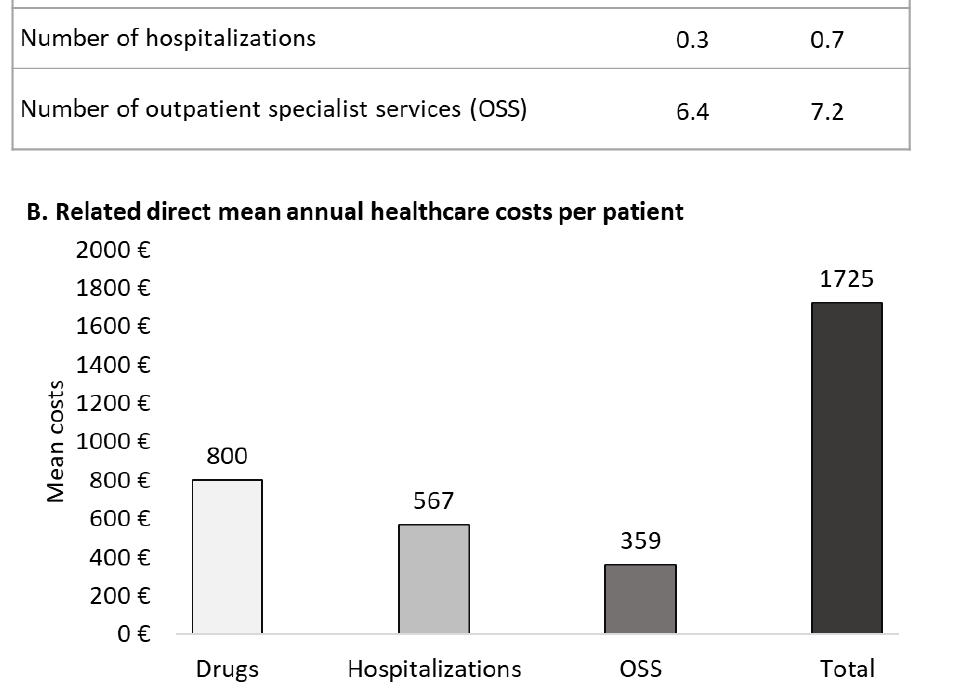
Figure 3. Mean annual healthcare resource consumptions ( A ) and related direct costs ( B ) over first year of follow-up in patients with glaucoma. The index-date was included in the cost analysis.